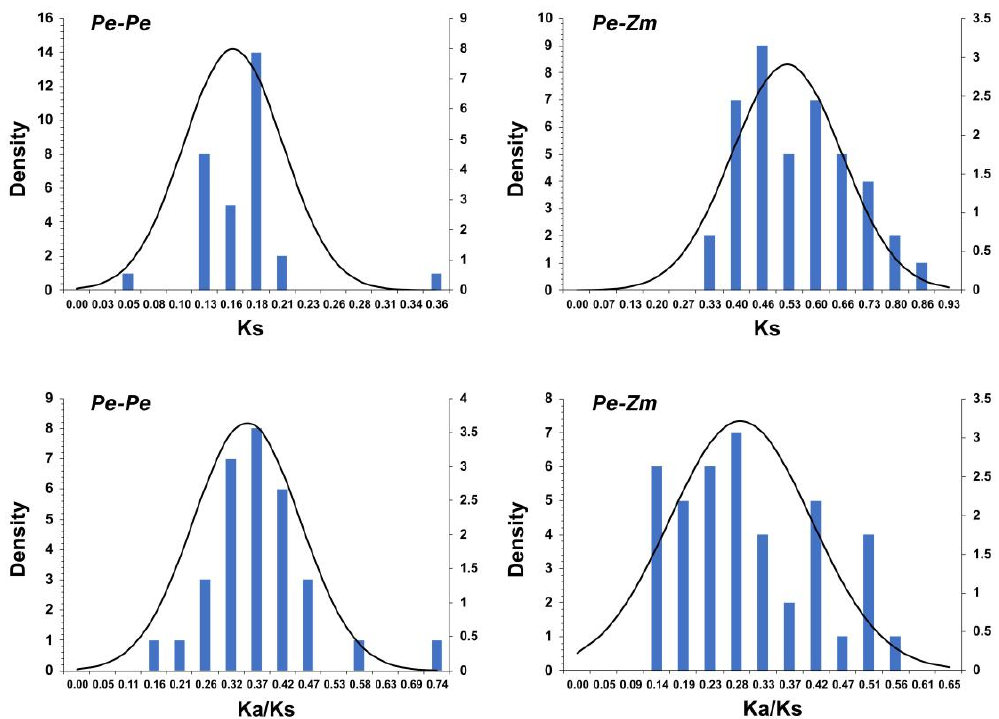
Figure 8. Ks and Ka/Ks value distribution of PeGLK genes in paralogous gene pairs (Pe-Pe) of moso bamboo genome and orthologous gene pairs between moso bamboo and maize, viewed through frequency distribution of relative Ks and Ka/Ks modes.